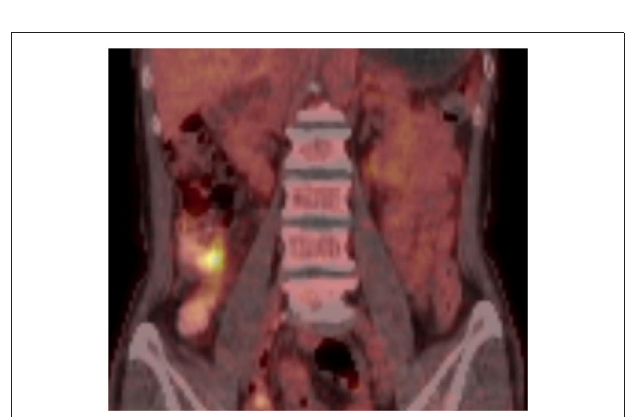
FIGURE 3 | PET-CT showed the increased metabolism (SUVmax: 9.3) of the lesion.